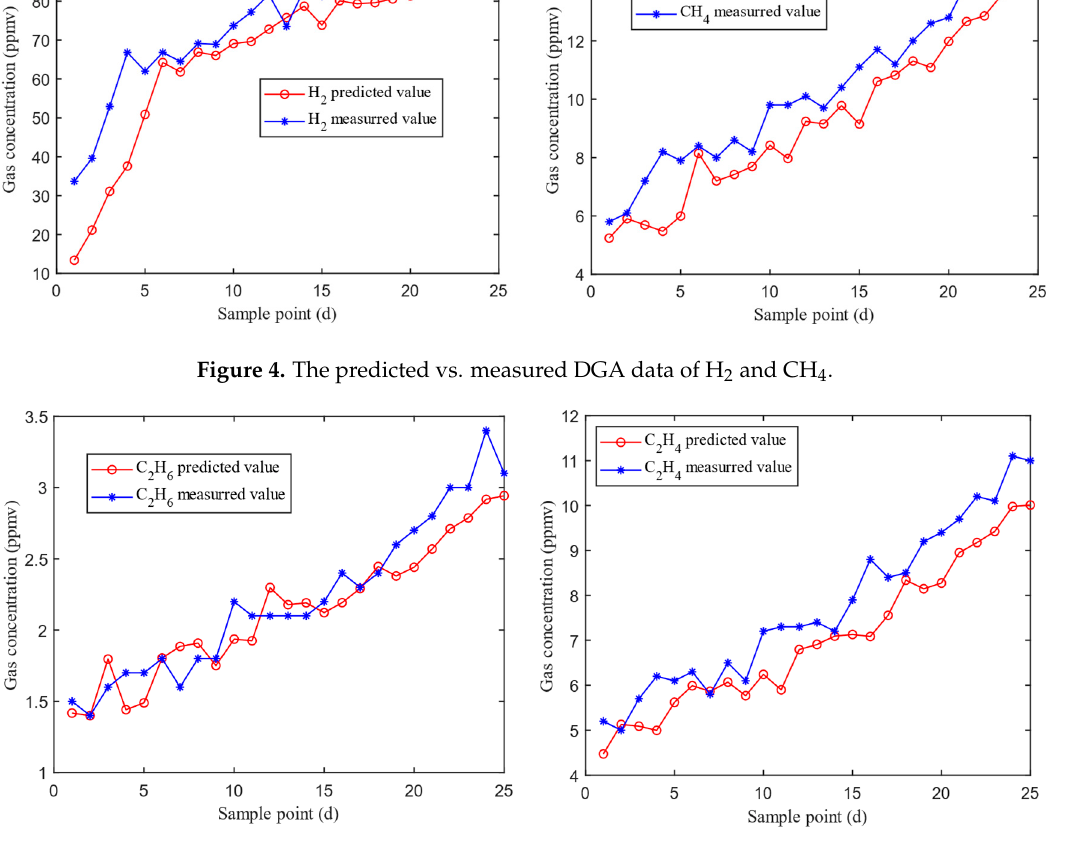
Figure 5. The predicted vs. measured DGA data of C 2 H 4 and C 2 H 6.